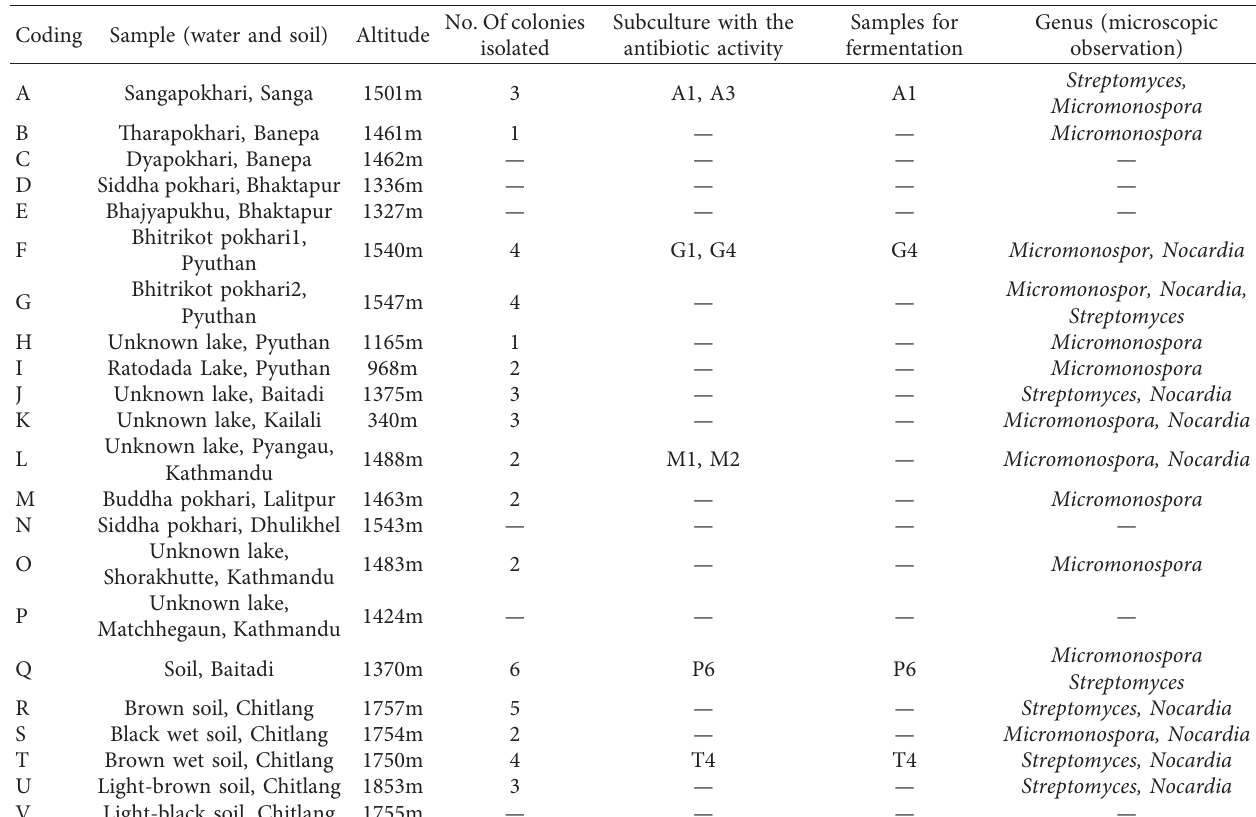
Table 2: Sample site, sample size, antibiotic producer, and Genus classification. Coding Sample (water and